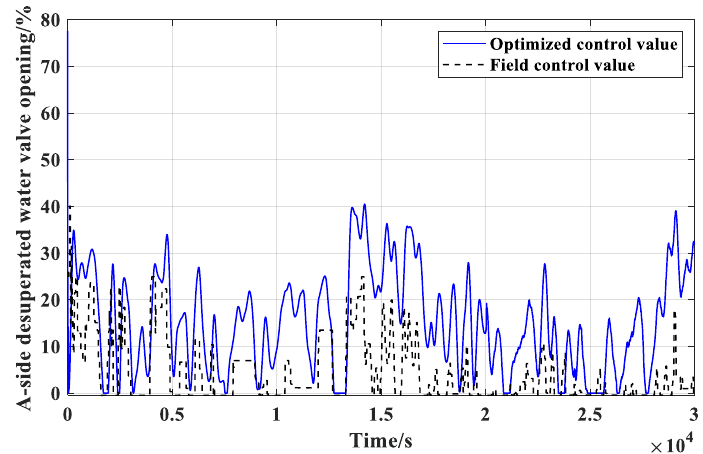
Figure 10. A-side control-variable comparison.